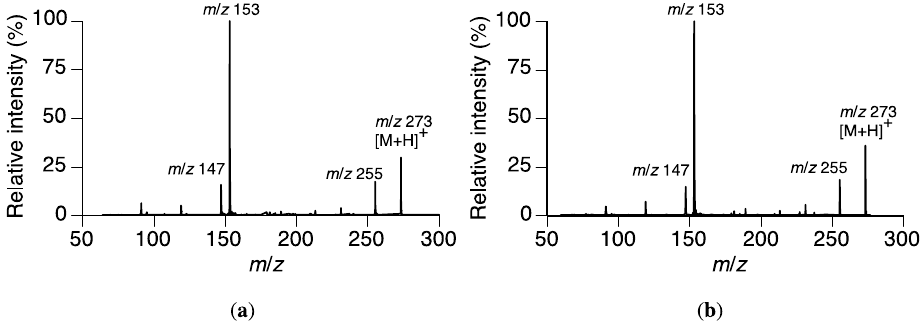
Figure 4. ESI-CID-MS results of a potential metabolite (peak II) in the Rhizoctonia solani suspension culture containing sakuranetin ( 1 ) and naringenin ( 2 ). ( a ) Peak II; ( b ) naringenin ( 2 ).